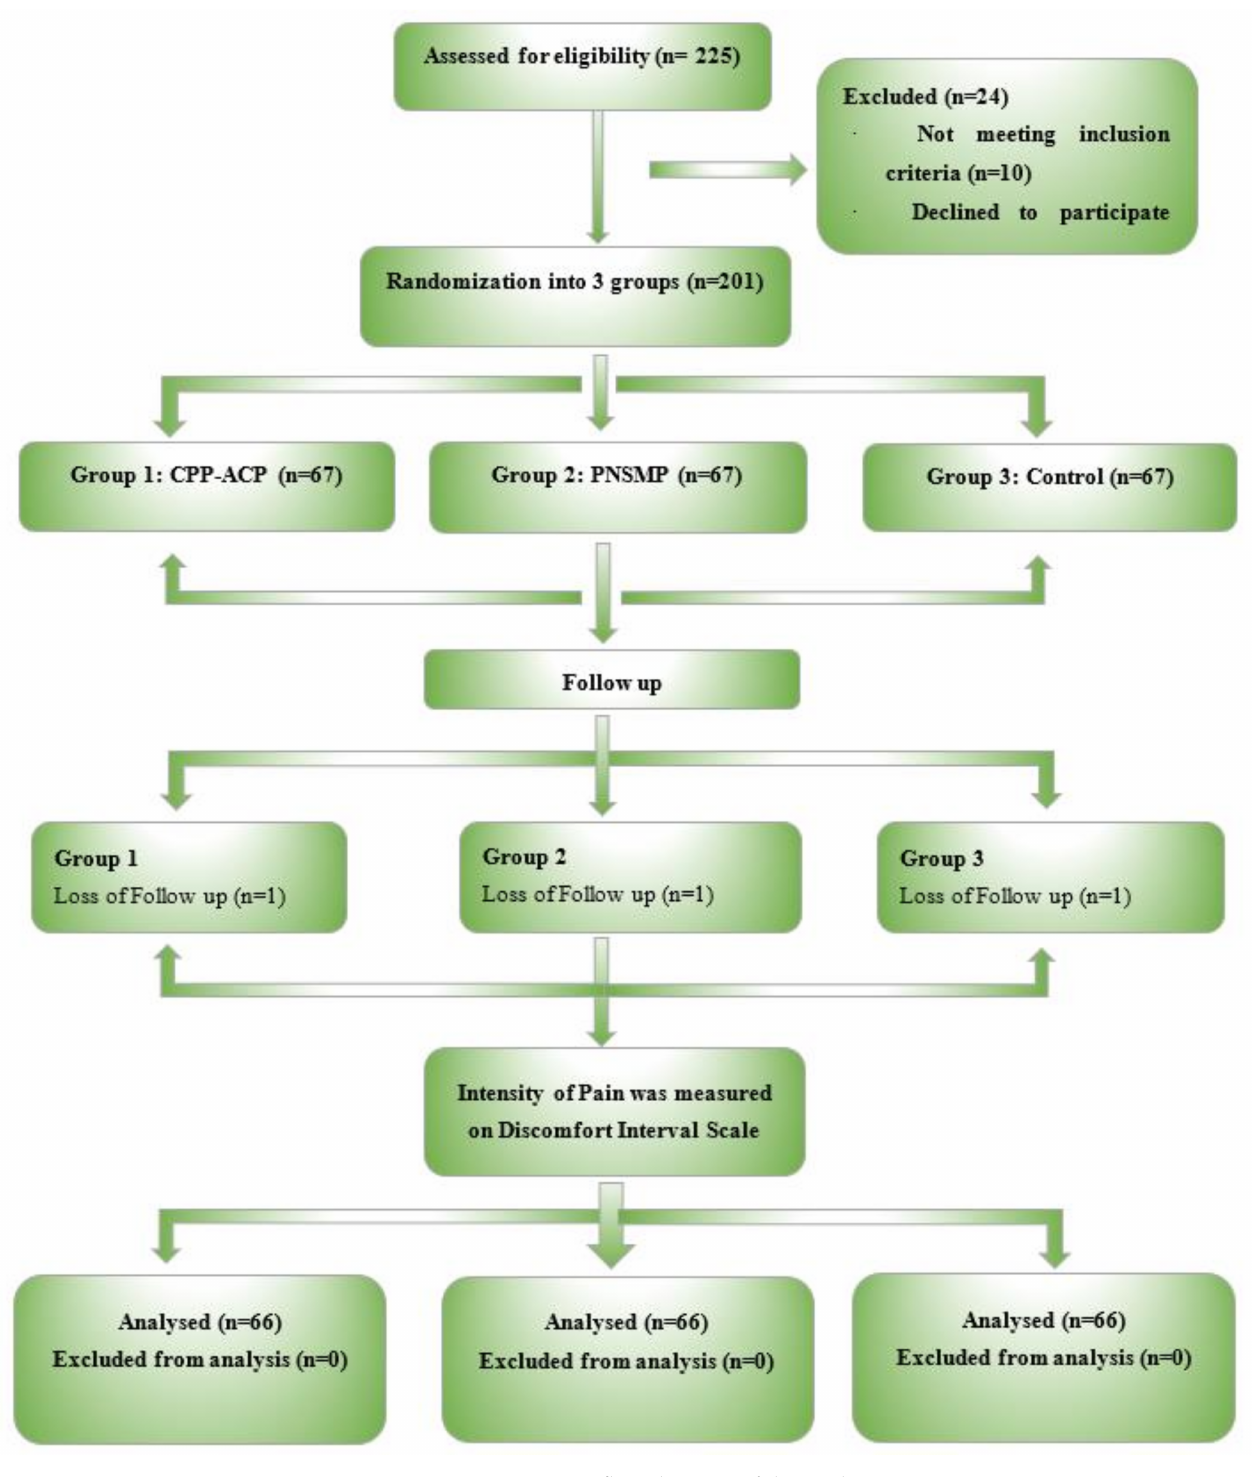
Figure 1. CONSORT flow diagram of the study. Lastly, after 36 h, the pain further decreased in group 1 and group 2 patients. In group